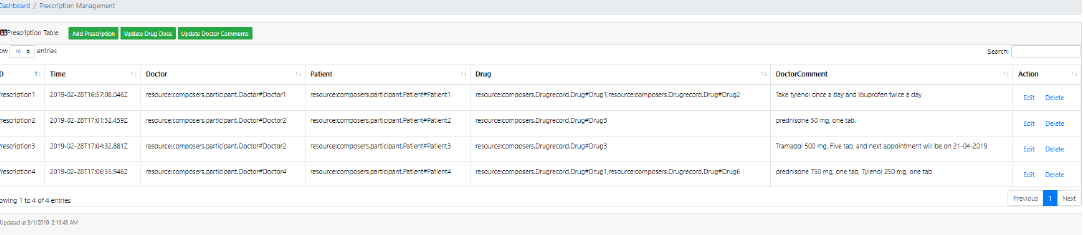
Figure 21. Prescription management dashboard.